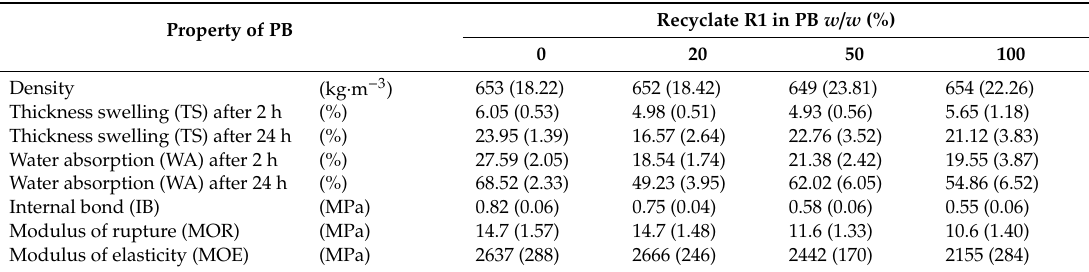
Table 3. Physical and mechanical properties of the control PB (PB-C) and of the PBs containing particles from a mixture of wood recycled products—R1.